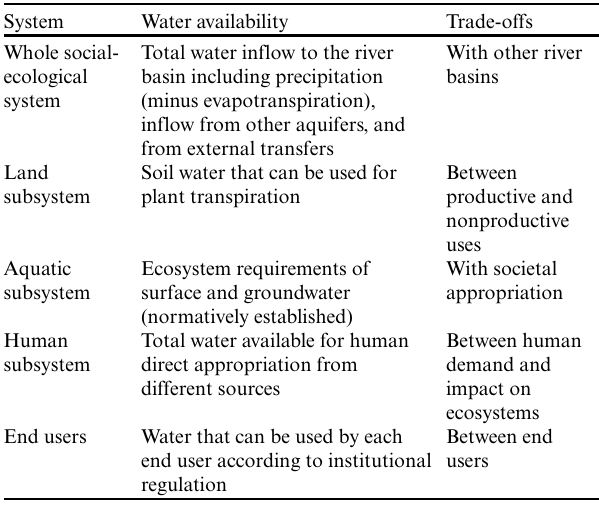
Table 2 . Water availability definitions for different